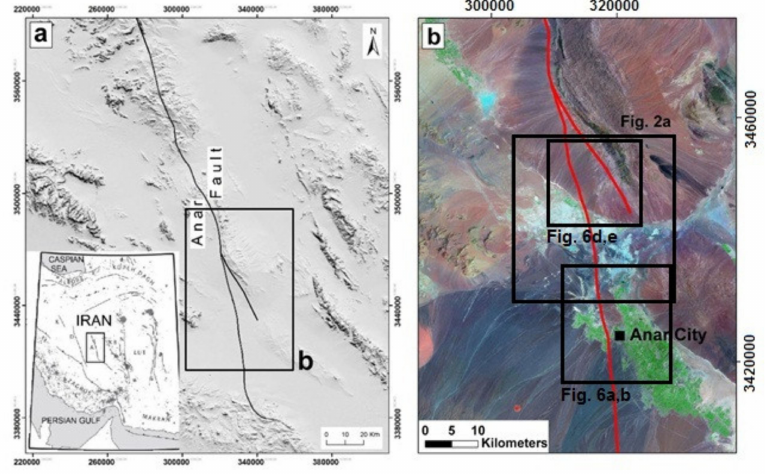
Figure 1. The study area and Anar fault in the Central Iran block (UTM Zone 40). Anar fault, with a length of approximately 200 km (Figure 2), is one of the active faults in Central Iran. The fault has a slip movement at 0.8 mm/year [14,54]. The northern part is in the mountainous region, and the southern part continues along the foothills to the Anar Salt Plan. Anar city is located in the south part, where the fault trace, ~30 m fault scarp, and displacement in streams are visible (Figure 2a–c). Due to the dense clay and sand cover around the fault, the mechanism in southern termination has not been determined by geomorphological evidence. Hence, both normal and reverse components may have created the scarp (Figure 2d,e). In this study, we were able to determine the type of right-lateral strike-slip and oblique fault mechanism.